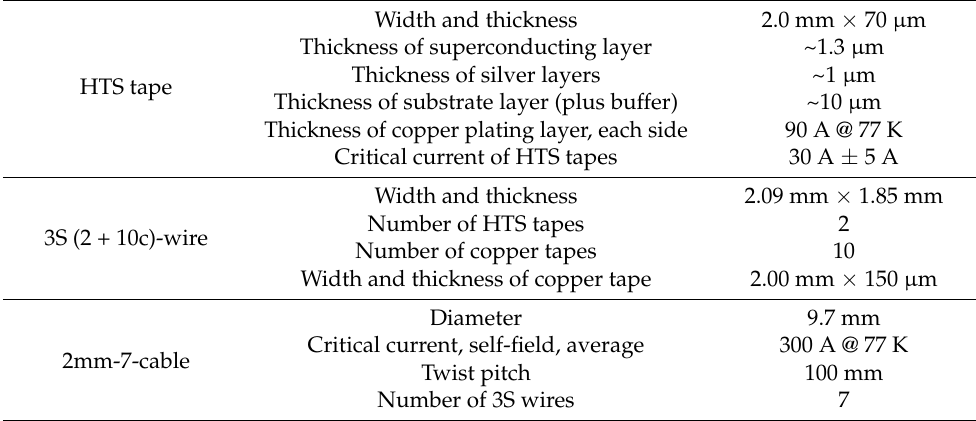
Figure 2. Cross-section view of 2 mm-7-cable and structure of 3S (2s + 10c)-wire with 2 mm width. Table 1. Specifications of HTS tape, 3S (2s + 10c)-wire, and 2